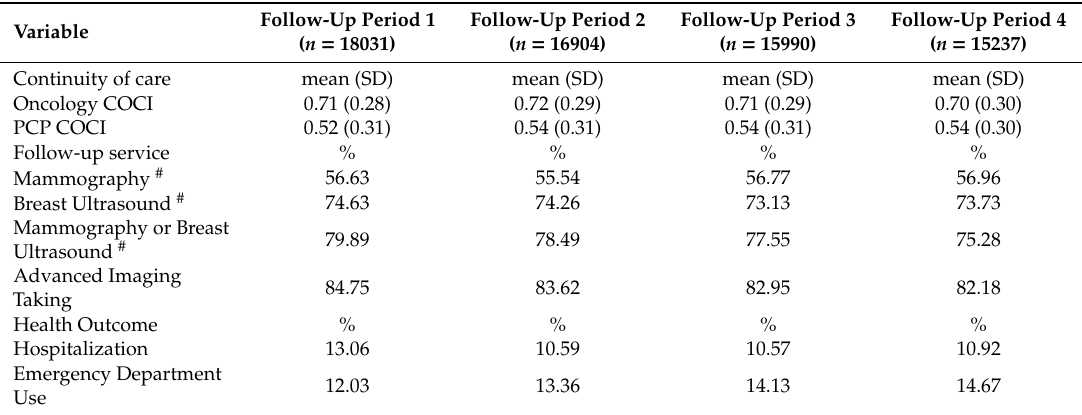
Table 3. Summary statistics for main interest variables according to follow-up